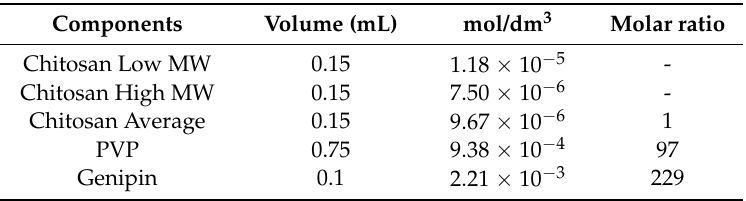
Table 2. Molar concentrations of hydrogel